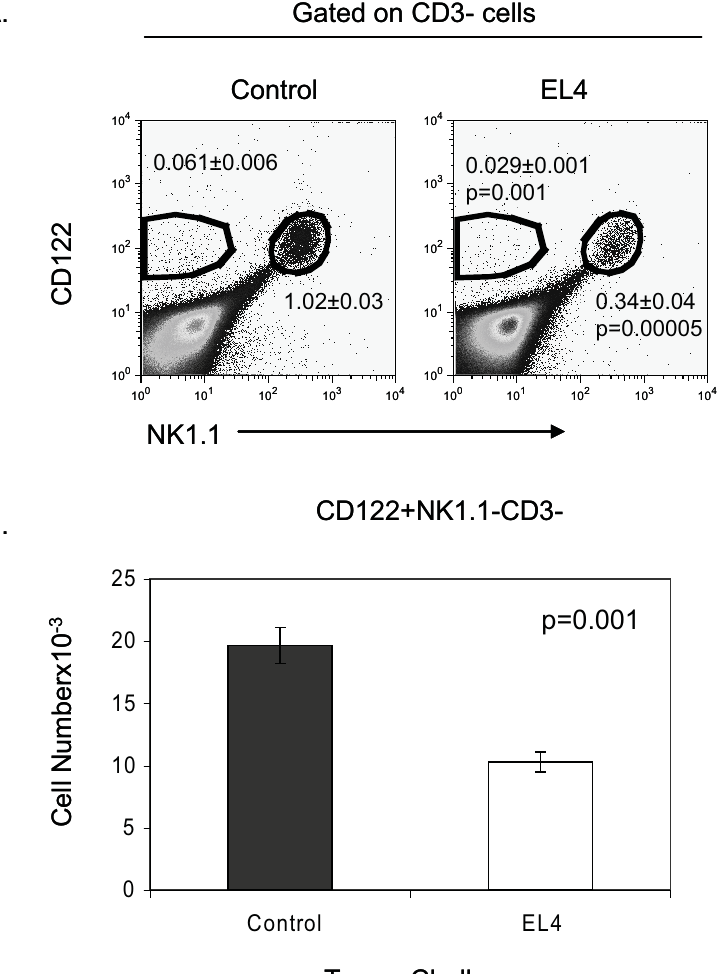
Figure 4. NK cell progenitors are reduced in EL4 tumor-bearing mice. B6 mice were injected with PBS or EL4 and sacrificed after 21 days. NK cell progenitors were characterized as CD122 + NK1.1 2 CD3 2 . A. FACs profile of NK cell progenitors. B. Absolute number of progenitors was calculated by multiplying the percentage of CD122 + NK1.1 2 CD3 2 cells by the total number of NK cells. Data shown were means and SEM, involving 4 mice per